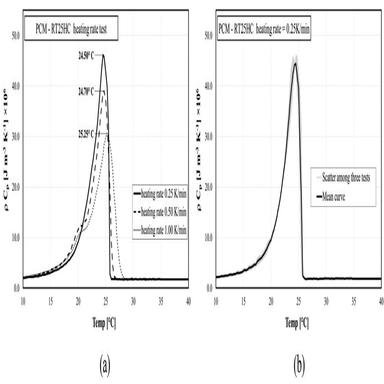
Results of DSC measurements in terms of ρ × Cp of PCM obtained with: (a) different heating rates (only the mean curves are shown) and (b) heating rates of 0.25 K × min–1.